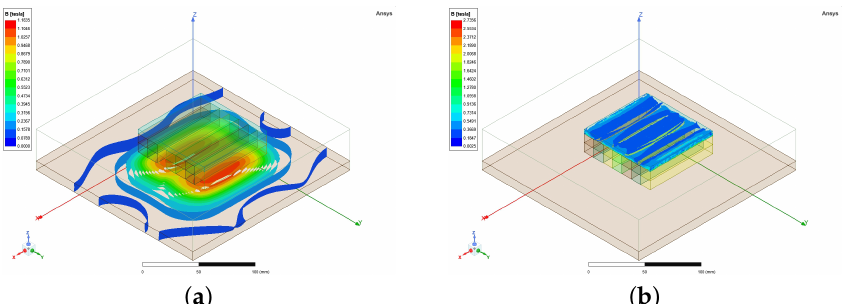
Figure 13. Simulation results for the proposed magnetization method. ( a ) Cloud map of the magnetic flux intensity on the test steel plate. ( b ) Cloud map of the magnetic flux intensity on the